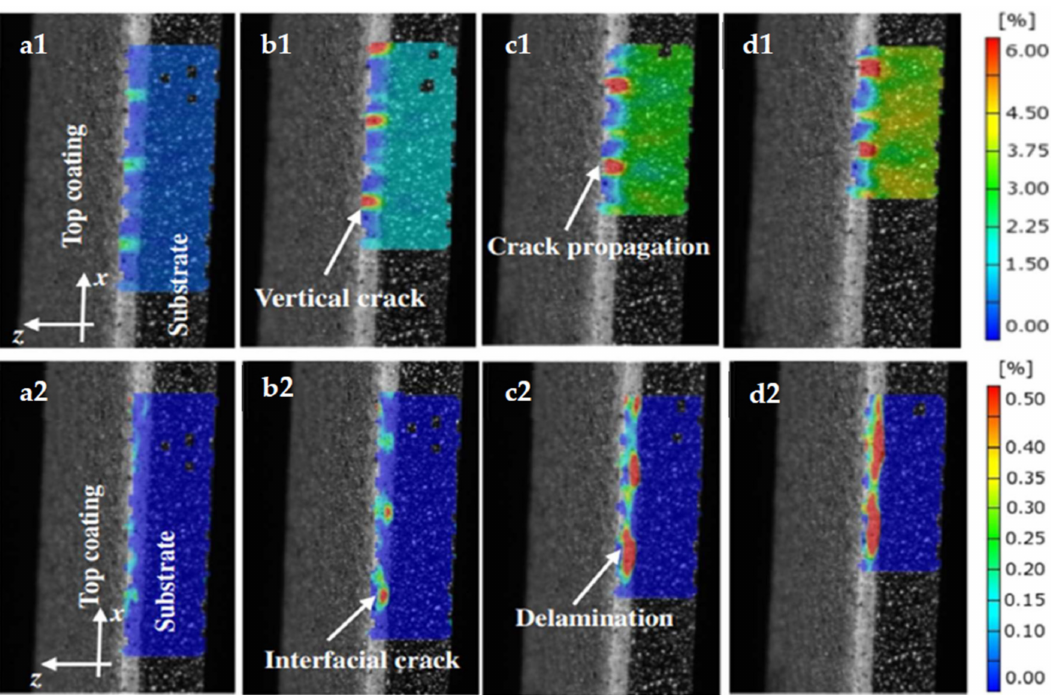
Figure 9. Development of the strain fields at the coating cross-section side under tensile experiments, where insets ( a1 – d1 ) denote the change of ε xx and insets ( a2 – d2 ) show the variation of ε zz